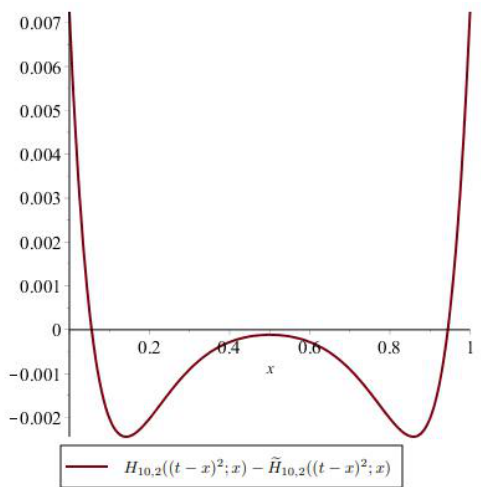
Figure 1. Difference in the central moments for n = 10, ρ = 2.